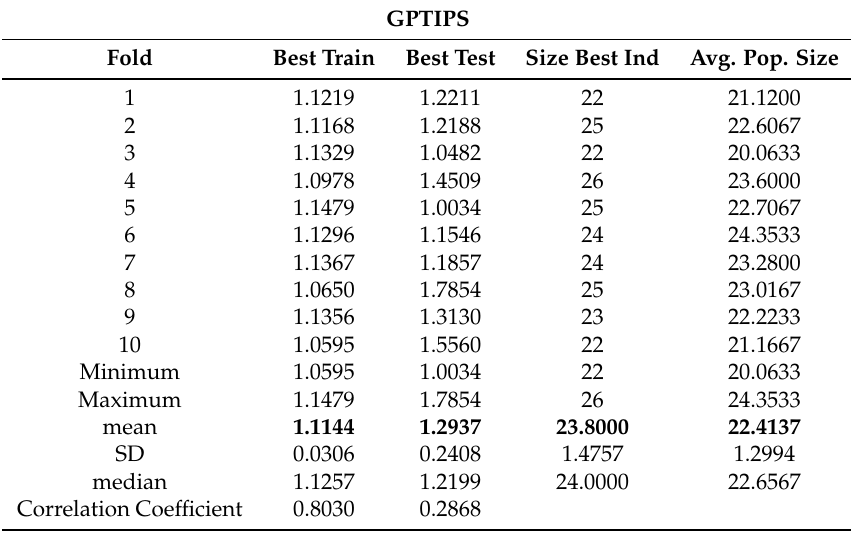
Table 3. Root Mean Squared Error (RMSE) for the 10-fold cross validation performance of GPTIPS on the 1–10 scale